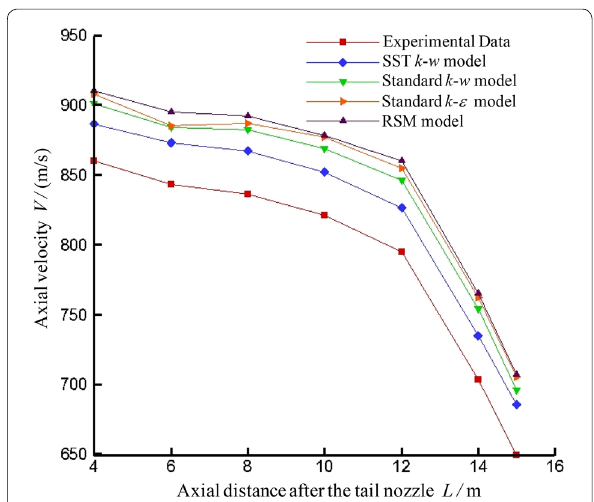
Figure 6 Axial velocity curve of gas jet from a single engine